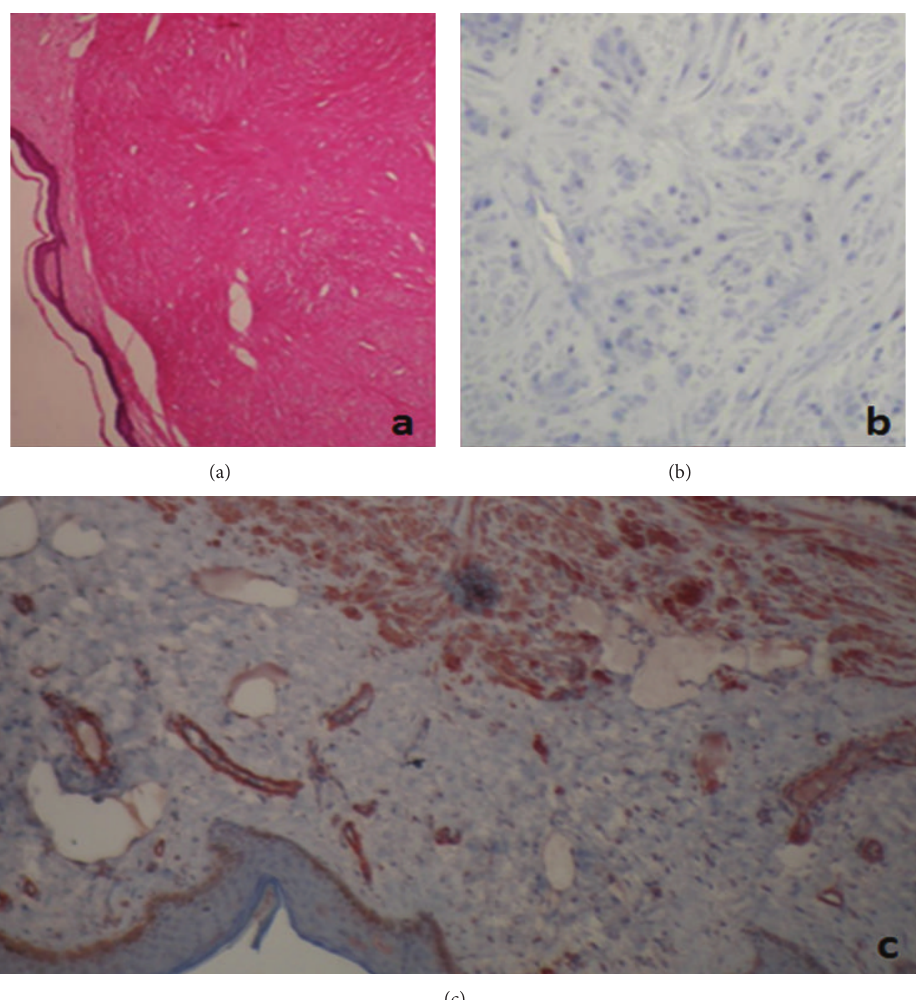
Figure 2: (a) H&E staining ×40 . (b) Masson trichrome staining ×400 . (c) SMA staining ×400